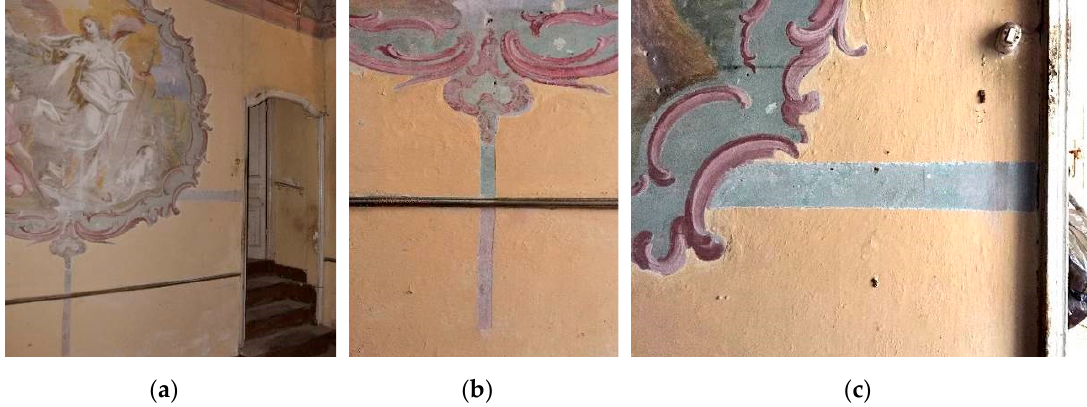
Figure 11. ( a ) Test performed in the second room (wall with San Giovanni Battista: vertical strip of 100 × 6 cm), ( b ) detail of the test with different plaster coloring in the lower and upper parts of the wooden molding and ( c ) test performed in the second room (wall with San Giovanni Battista: horizontal strip of 100 × 10 cm).